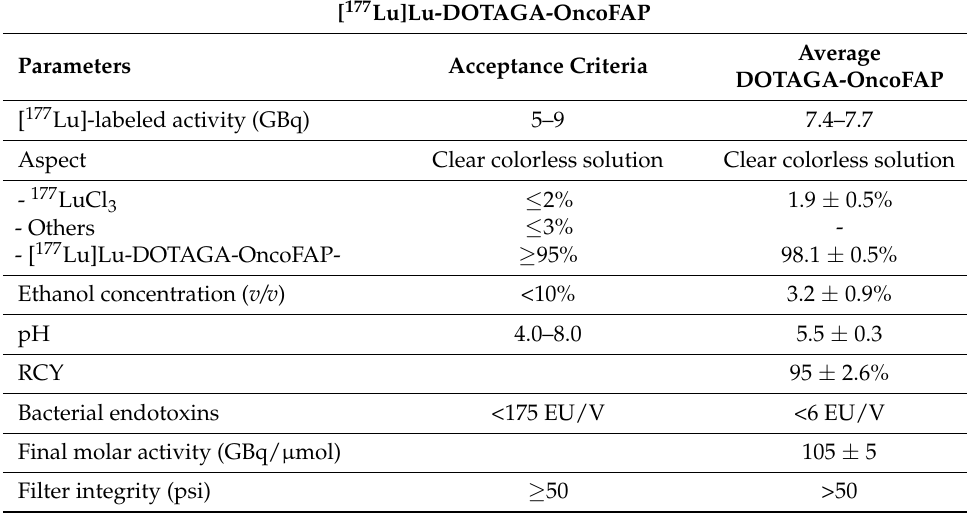
Table 11. Acceptance criteria and average result of three synthesis of [ 177 Lu]Lu-DOTAGA-OncoFAP condition